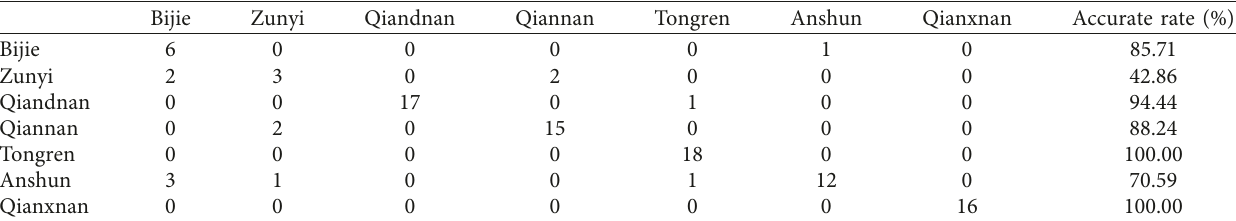
Figure 2: PLS-DA identification model of seven different geographical origin of sauce-flavor baijiu (Chinese baijius) from Guizhou Table 7: Nineteen classification results by PLS-DA for seven different origins.